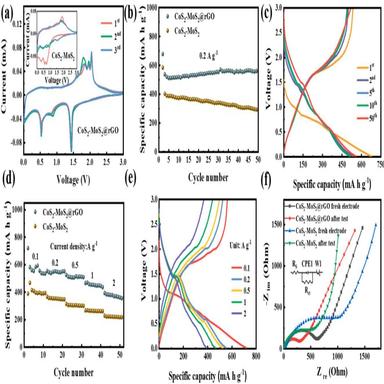
Electrochemical performance of CoS2-MoS2@rGO for SIBs: (a) CV curves at 0.1 mV s − 1 (the inset is the CV curves of CoS2-MoS2), (b) cycling performance in comparison of CoS2-MoS2 at 0.2 A g− 1 , (c) galvanostatic charge/discharge curves at various cycles, (d) rate capability in comparison of CoS2-MoS2 at various current densities, (e) galvanostatic charge/discharge curves at various current densities, and (f) Nyquist plots of the electrodes before and after 50 cycles in comparison of CoS2-MoS2.